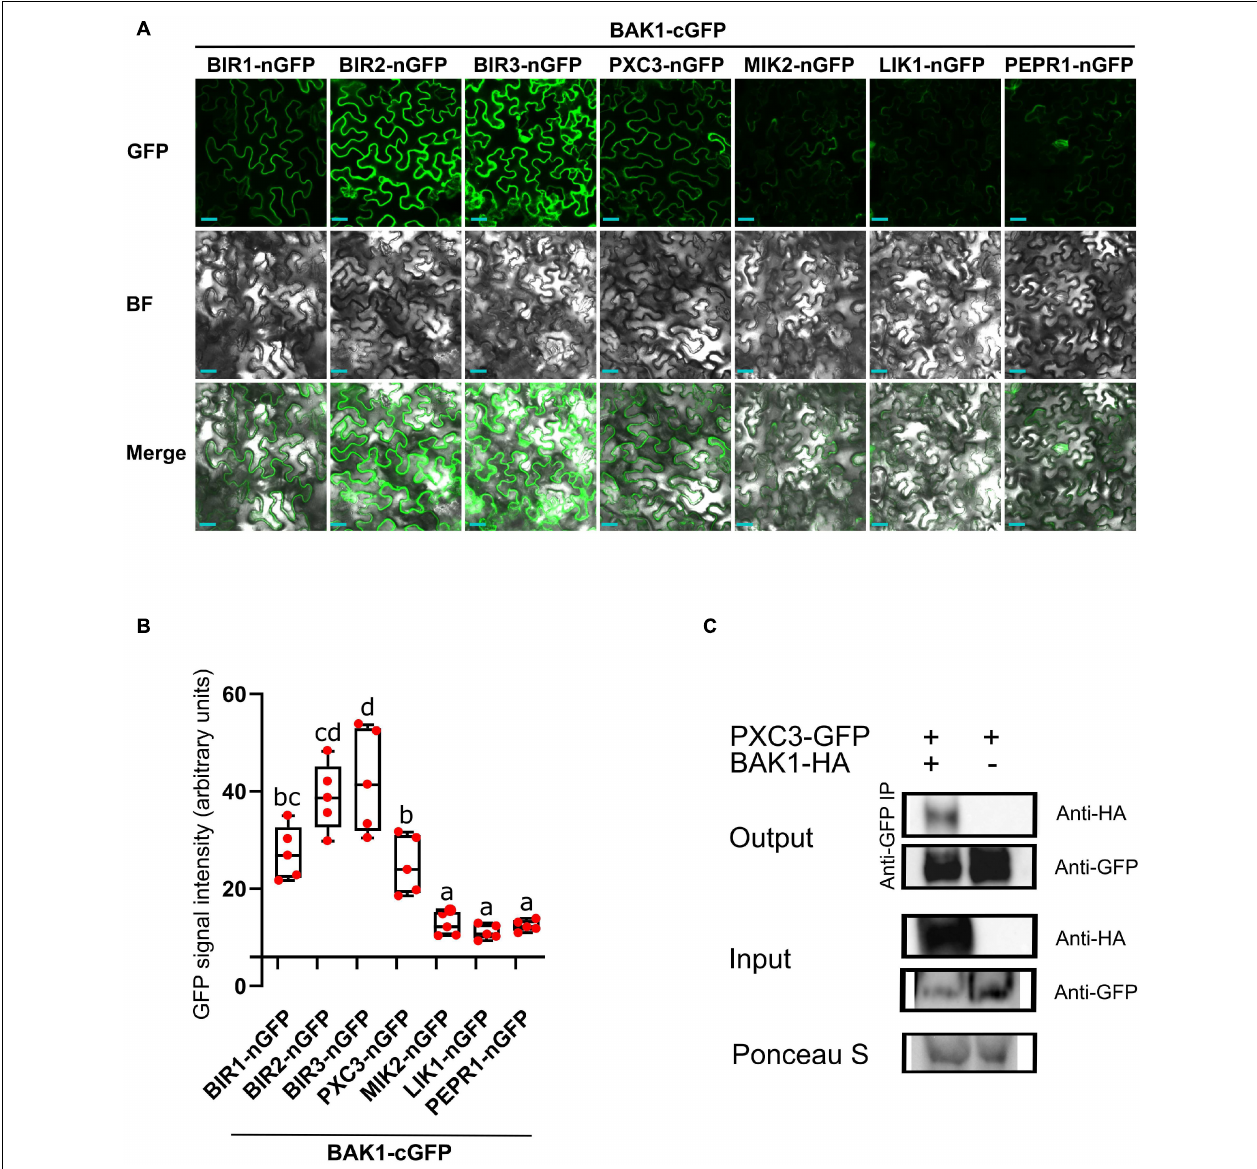
FIGURE 1 | BAK1 interaction with identified LRR-RLKs. (A) BIFC experiments after transient expression in tobacco leaves of BAK1 and other receptors fused to the C-term or N-term halves of GFP, respectively. Scale bars represent 20 µ m. This experiment was done three times with similar results. BF, bright field. (B) Quantification of the mean GFP signal in BIFC experiments. Individual data points represent values for different leaves (average of 5 images per interaction per leaf). A one-way ANOVA analysis was performed followed by Tukey’s test and the lowercase letters indicate statistical differences ( P < 0.05). (C) Co-immunoprecipitation assay between BAK1 and PXC3 proteins. Protein extracts obtained from tobacco leaves infiltrated with Agrobacterium harboring 35Spro:BAK1-HA and 35Spro:PXC3-GFP were analyzed by western blot using anti-GFP and anti-HA